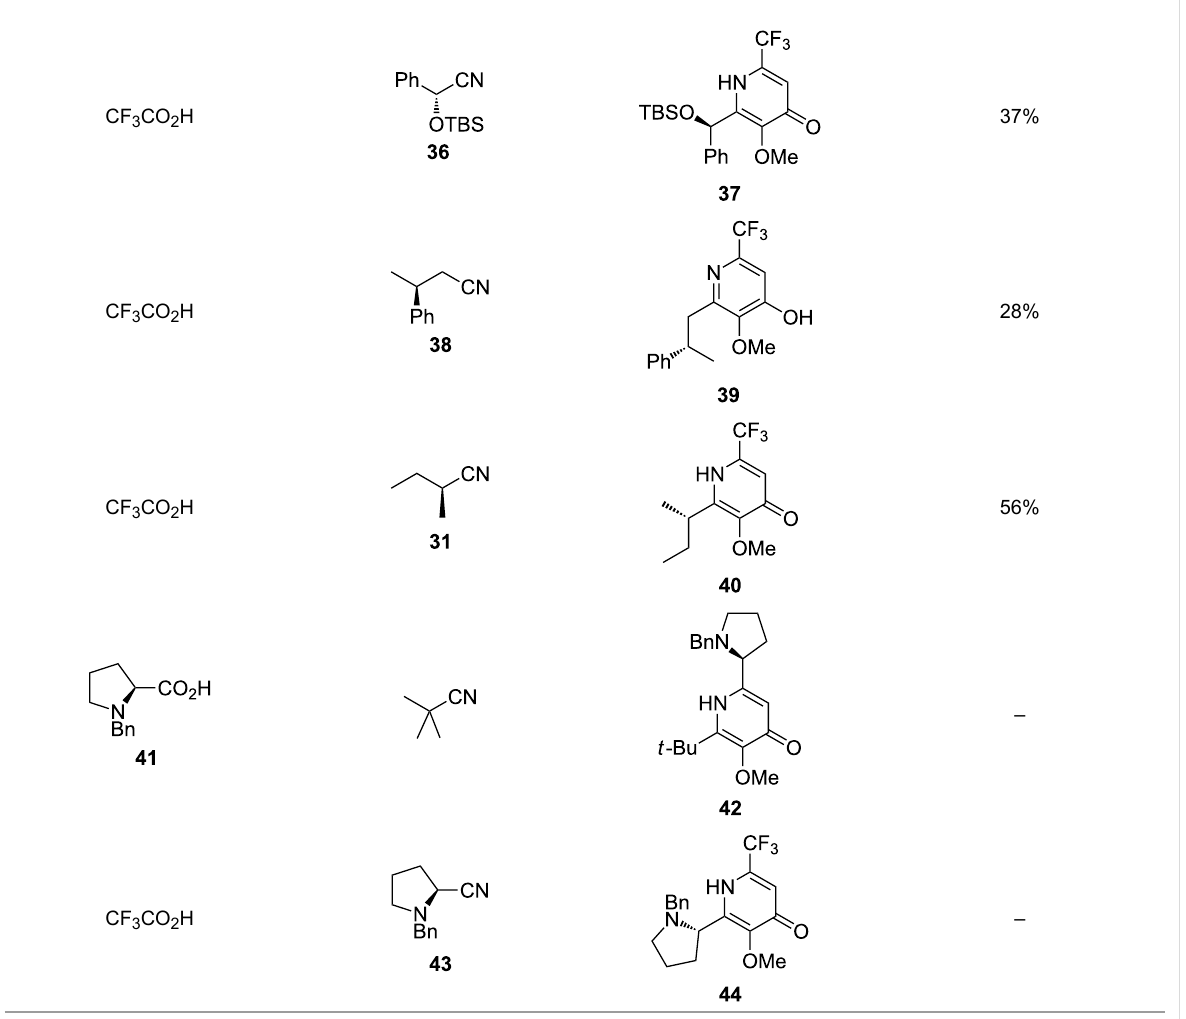
Table 1: Scope of the synthesis of 4-hydroxypyridine derivatives from lithiated methoxyallene, nitriles and carboxylic acids.